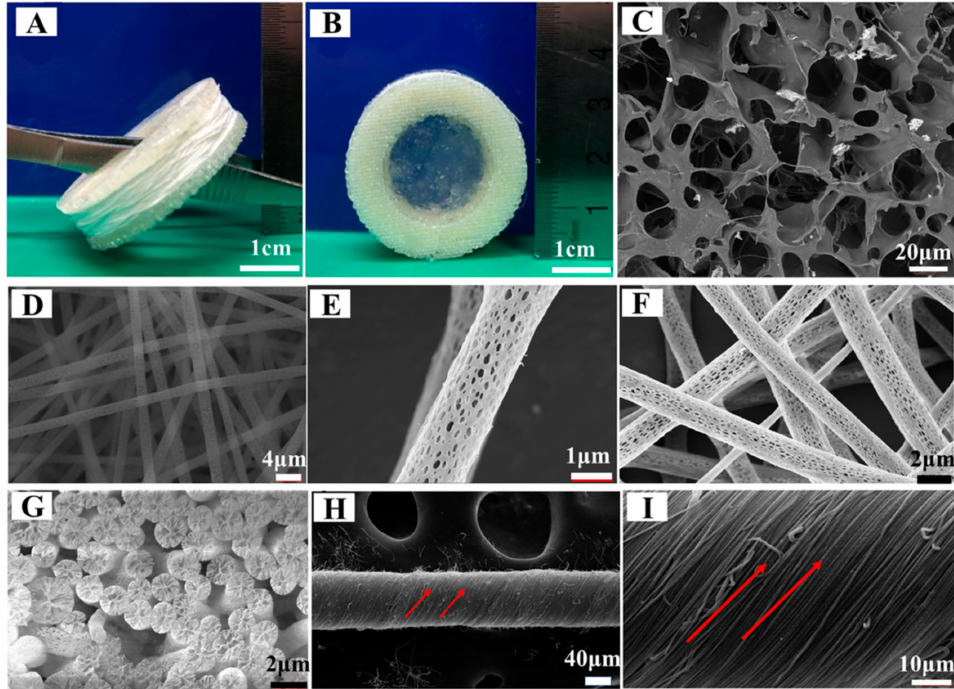
Figure 4. Morphology of the biofabricated artificial intervertebral disc. ( A ) Macro side view and ( B ) Macro front view of the scaffold. ( C ) SEM image of the nucleus pulposus part hydrogel. ( D – G ) SEM images of PLLA fibers. ( H , I ) SEM images of annulus fibrosus part fiber bundle [Reprinted with permission from Ref.